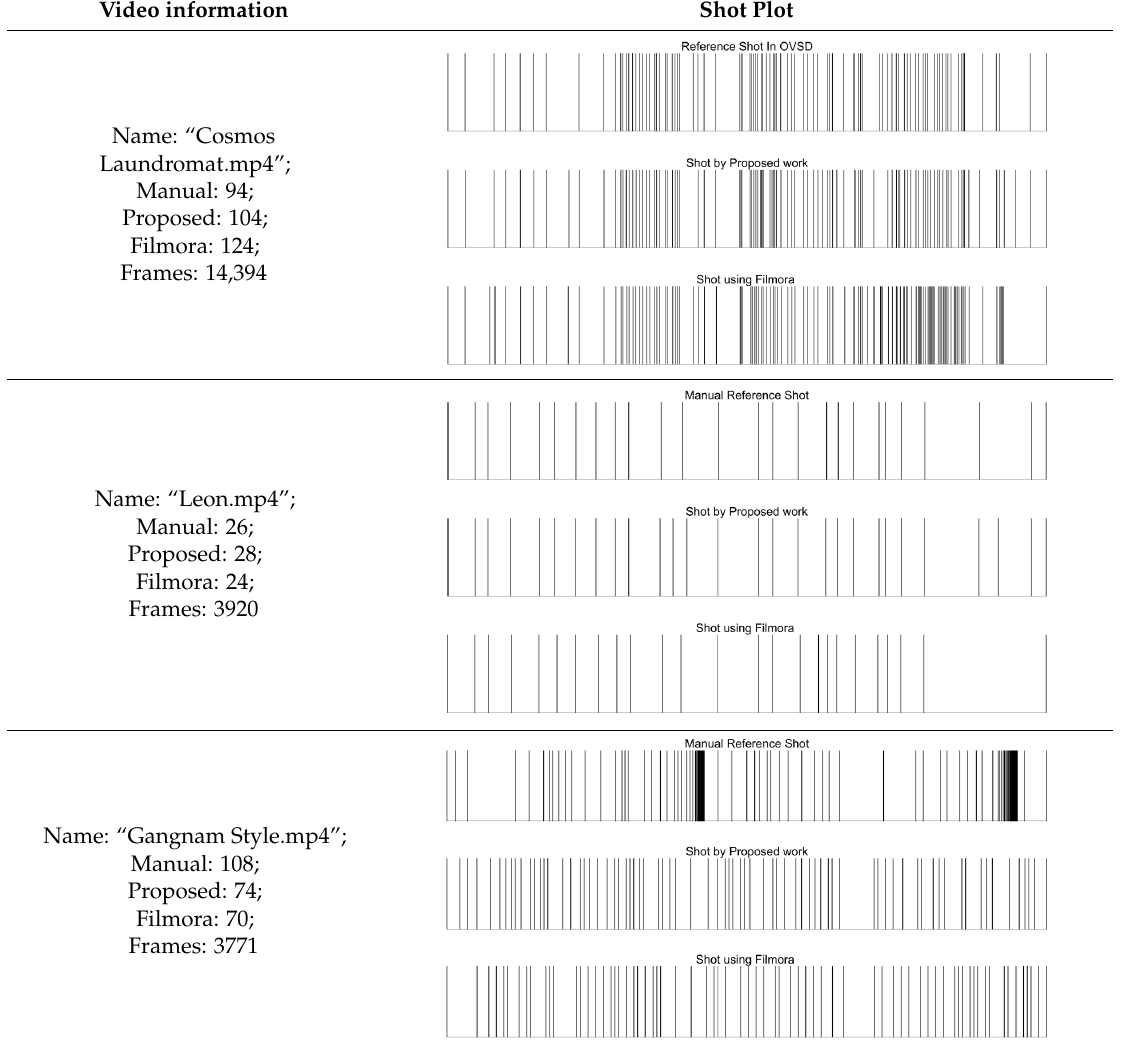
Table 10. Cont. Video information Shot